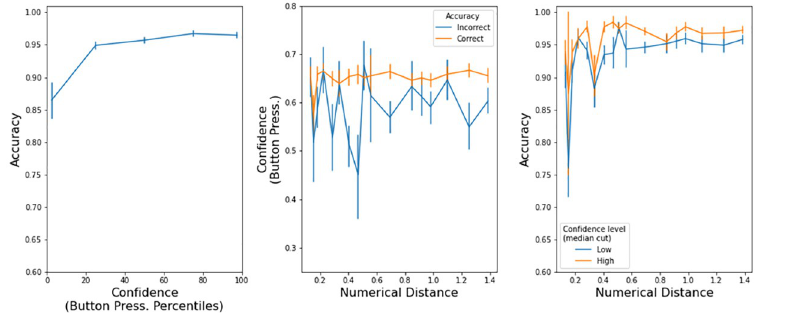
Fig 11. Confidence characteristics in button pressure (Exp. 3). Error bars are s.e.m.